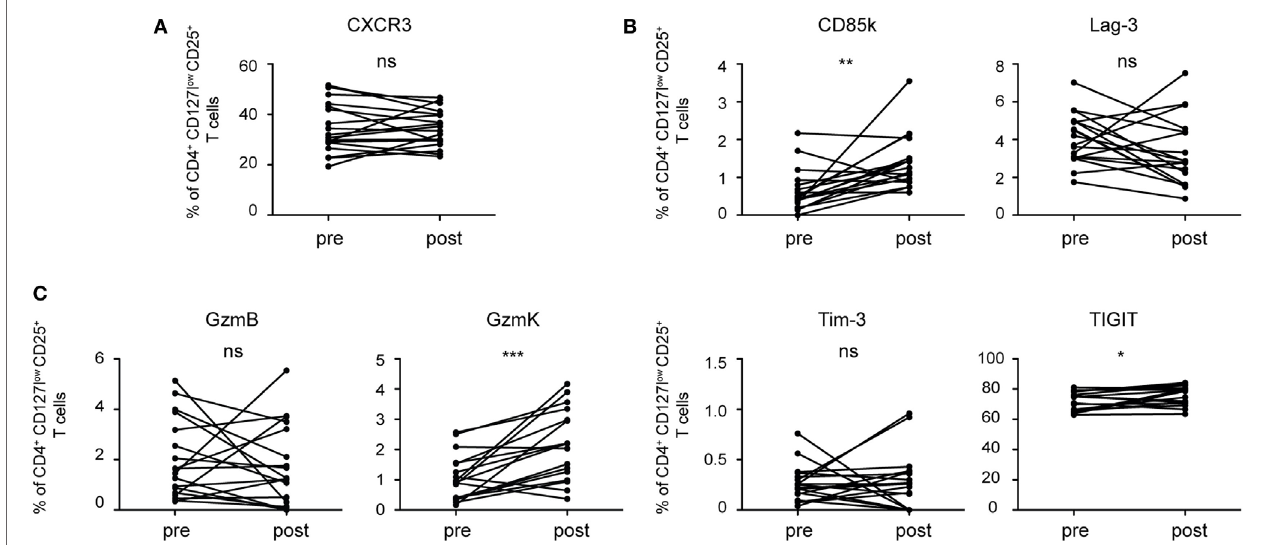
FigUre 7 | Human Treg cells induce co-inhibitory receptors and cytotoxic molecules during a Th1 immune response. Treg cells from PBMCs of healthy donors were analyzed ex vivo by flow cytometry before (pre) and 7 days after (post) influenza vaccination for expression of (a) the surface receptor CXCR3, (B) the co-inhibitory receptors Tim-3, CD85k, Lag-3, and TIGIT as well as (c) the cytotoxic molecules granzyme B and K. Frequencies of CD4 + CD127 low CD25 + Treg cells expressing the indicated markers are shown and pre- and post-vaccination samples from the same donor are connected by lines ( n = 18). * p < 0.05, ** p < 0.01 (Wilcoxon matched pairs test, D’Agostino and Pearson omnibus normality